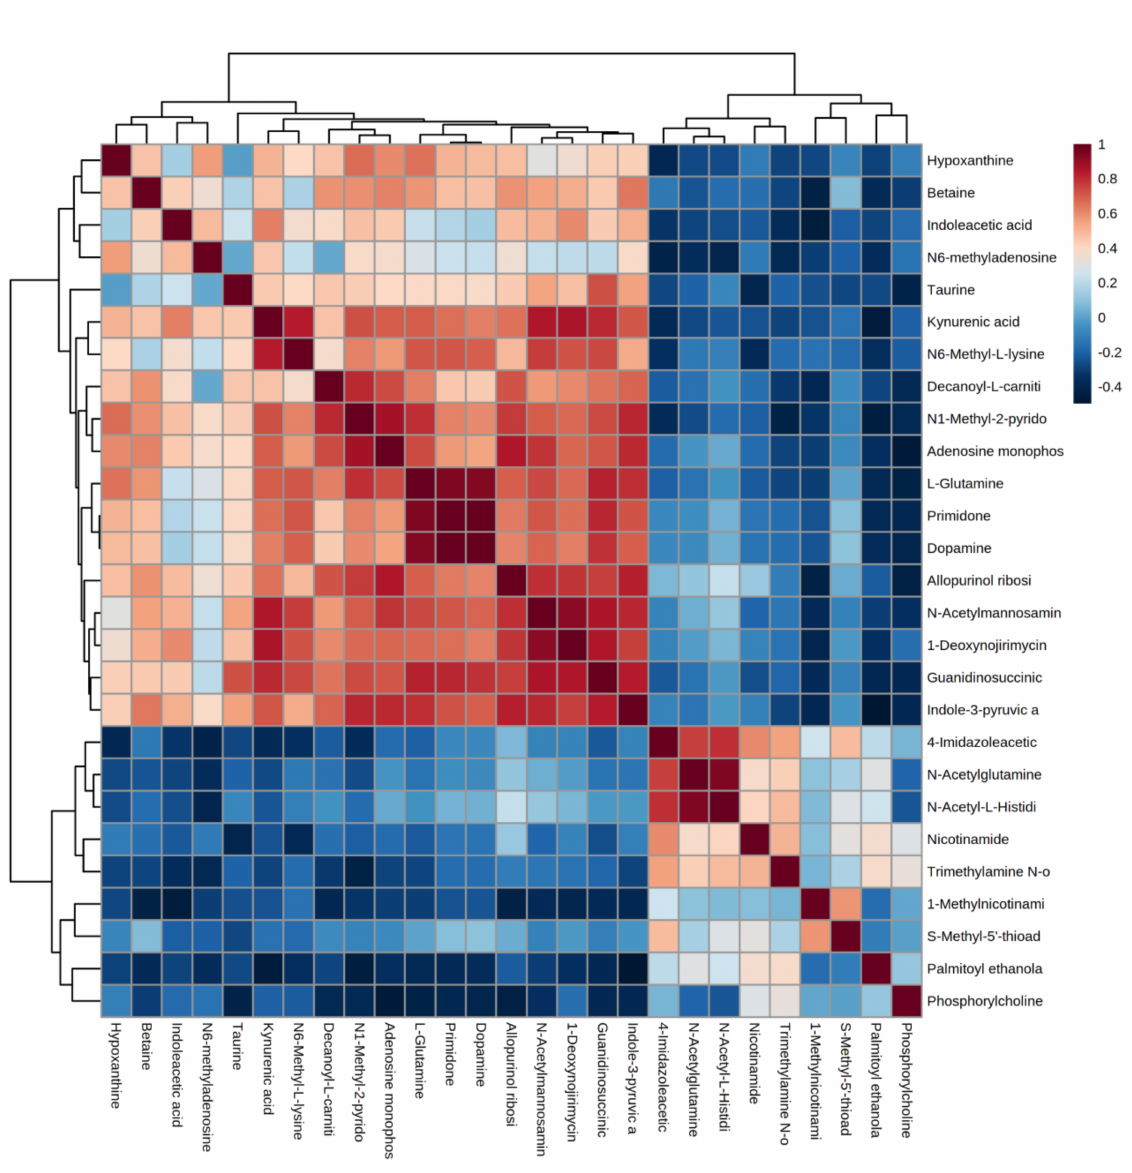
Figure 4. Correlation analysis of differential metabolites after water polo